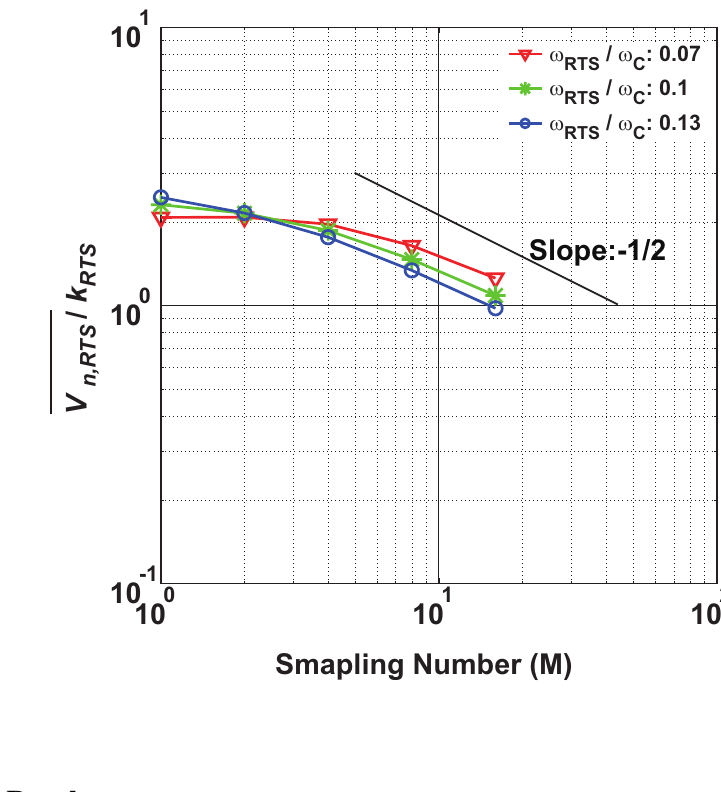
Figure 8. Estimated RTS Noise Amplitude as a function of